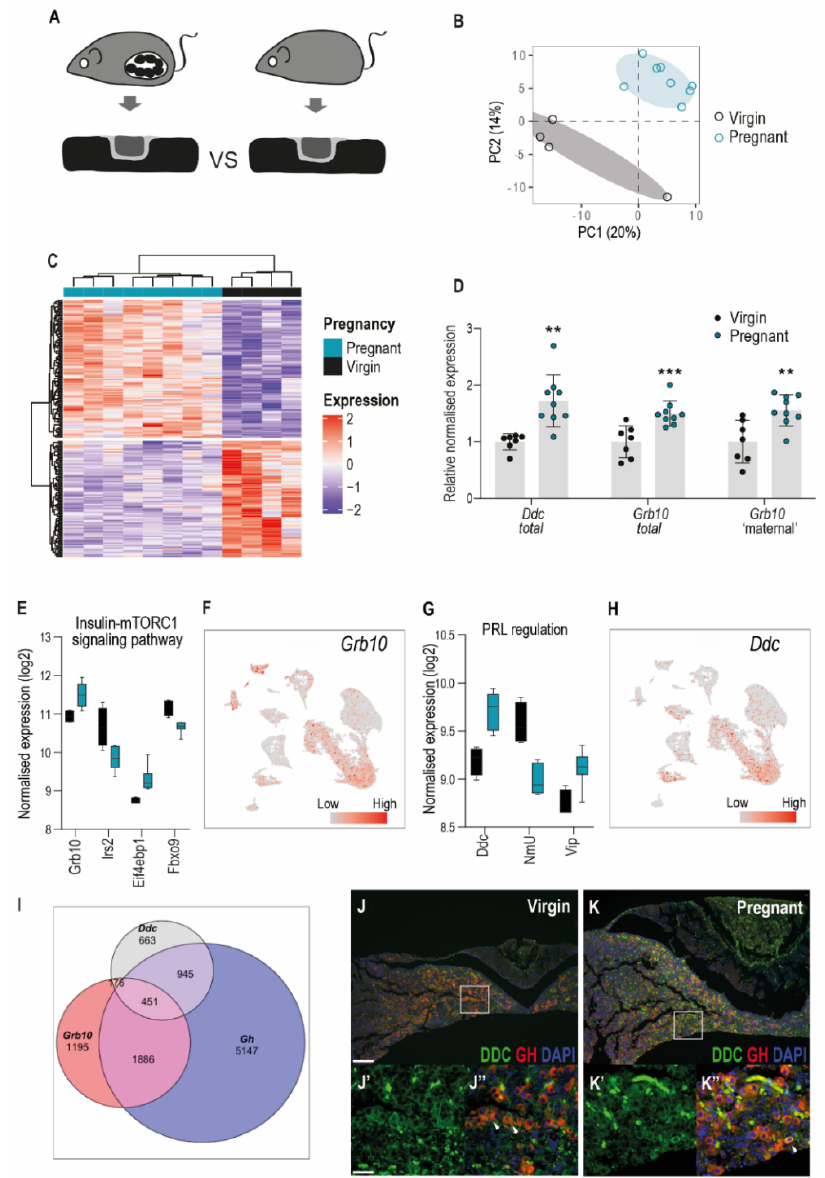
Figure 4. Transcriptional profiling of the pregnant pituitary gland at e15.5. Experimental schema: whole pituitary was removed from pregnant or virgin c57BL6/J mice at 3 months and compared ( A ). Non-supervised clustering indicates that the samples cluster according to experimental group ( B ). Heatmap showing genes which were differentially expressed in the whole pituitary of pregnant ( n = 8) and virgin ( n = 4) females ( C ). Statistical significance for differential expression between the groups was determined based on a p -value (corrected for multiple hypothesis testing based on the Benjamini– Hochberg procedure) threshold of 0.05 and a fold change threshold of 1.25. Probe signal intensities were quantile normal- ised and z-transformed across samples (see Materials and Methods). Real-time quantitative PCR validation of candidate gene expression in pituitaries from an independent cohort of e15.5 pregnant ( n = 9) and virgin ( n = 7) mice at 3 months ( D ). Data were normalised to housekeeping gene expression and depicted as mean relative expression ± SD (bars and error). Groups were called significantly different by Student’s t-test (** p < 0.01, *** p < 0.001). DE genes in the Insulin- mTORC1 pathway from the transcriptomics data shown in C ( E ). Feature plot showing the scRNAseq distribution of growth factor receptor-bound protein 10 ( Grb10 ) ( F ). DE genes in prolactin (PRL) pathway from the transcriptomics data shown in C ( G ). Feature plot showing the scRNAseq distribution of Ddc ( H ). Venn diagram showing overlap of cells from scRNAseq data that express linked Grb10 and Ddc and Gh ( I ). Immunofluorescence showing DDC expression in the adult virgin ( J ) and pregnant ( K ) gland with zoom into the anterior lobe parenchyma as single channel ( J’ , K’ ) and overlap of DDC, GH and DAPI signals ( J’’ , K’’ ). Overlap of DDC and GH immunoreactivity is evident in a subset of AP cells (white arrows). Box-and-whisker plots show the mean and min-max range of the data. Scale bars represent 500 μ m for the low- magnification images and 50 μ m for the enlarged images.